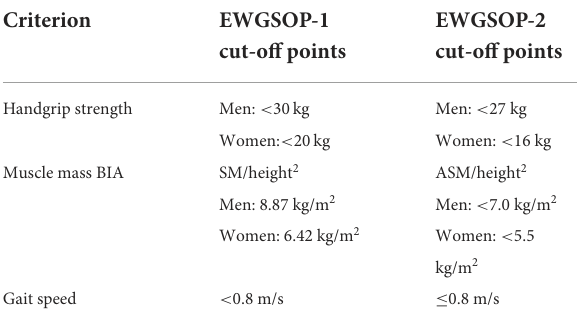
TABLE 1 EWGSOP-1 and EWGSOP-2 cut-off points for sarcopenia. TABLE 2 Sex differences in demographic and clinical